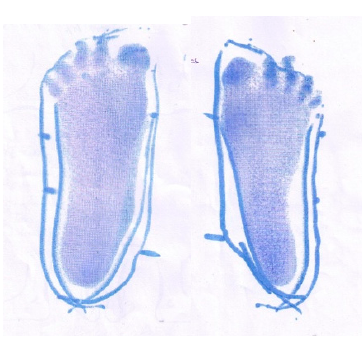
Figure 11. Participant 8 left and right initial pedograph footprint (15 June 2016).